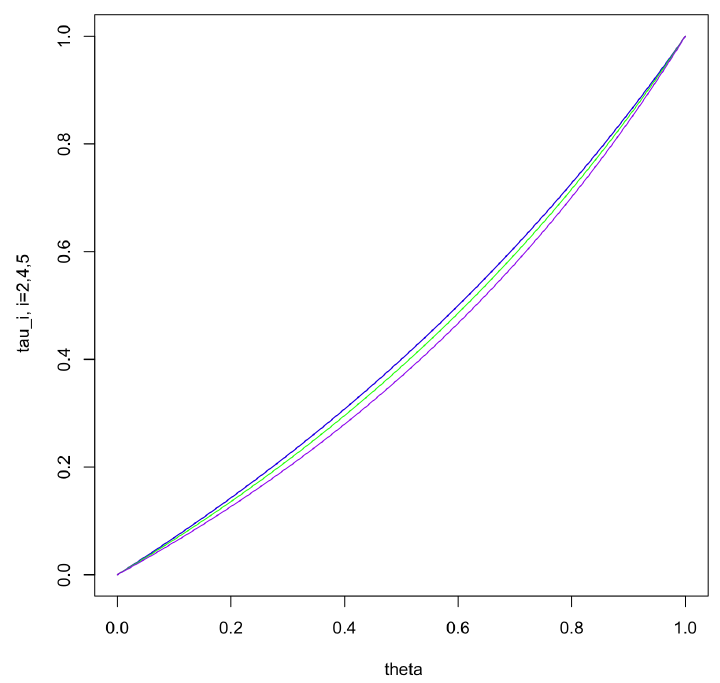
Figure 2. The curves of τ 2 , τ 4 and τ 5 in terms of θ are indicated with colors blue, green and purple,